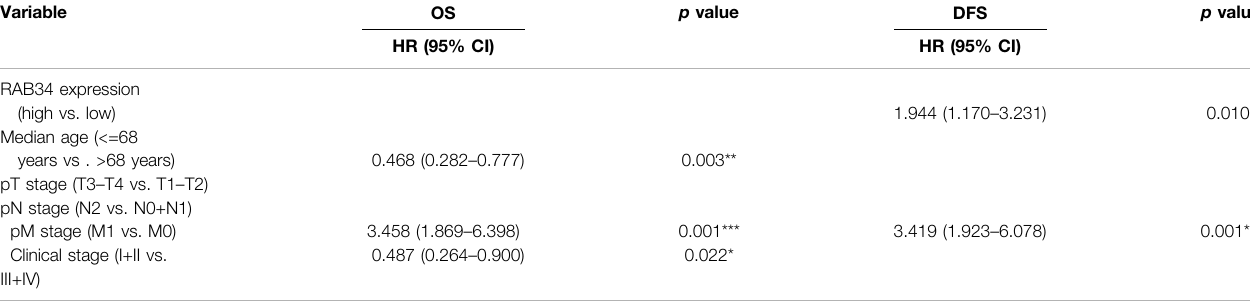
TABLE 2 | Multivariate Cox regression analysis of RAB34 mRNA expression in CRC patients from